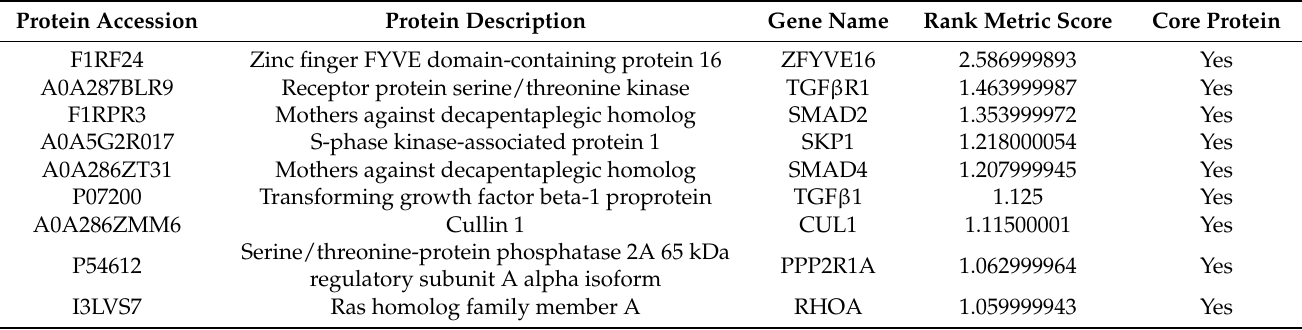
Table 1. Core proteins that promoted upregulation of the TGF- β signaling pathway.